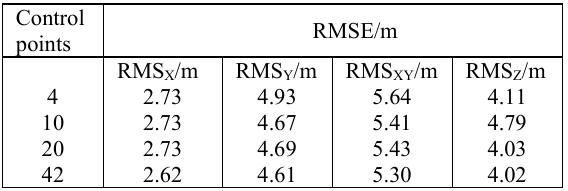
Table 4. Stereo positioning results after constant angular model